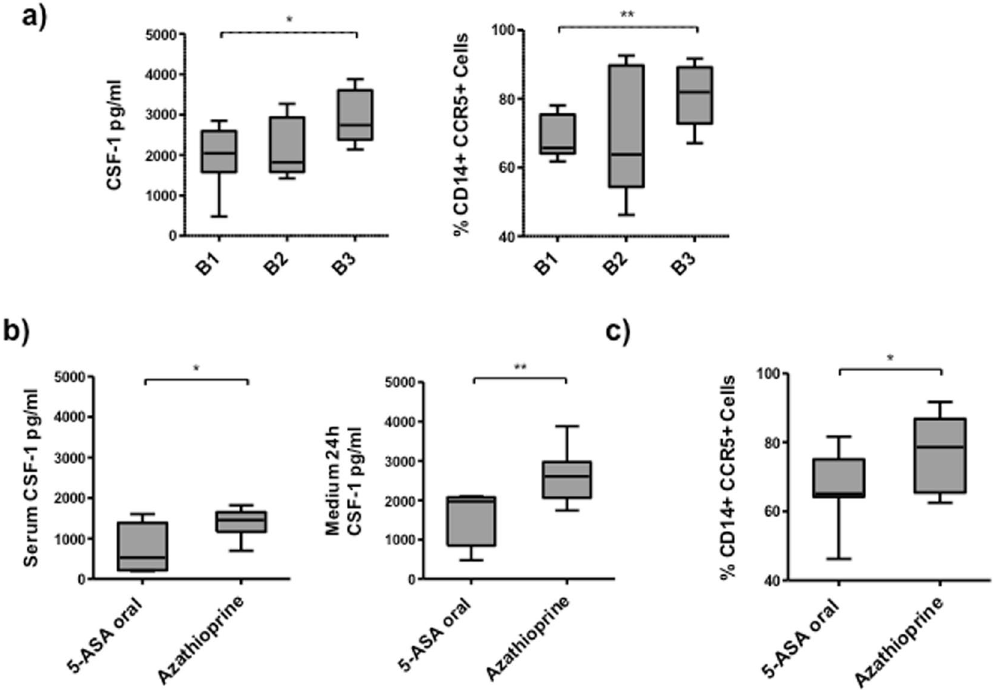
Figure 6. CSF-1 and CCR5 expression was associated with clinical behavior and treatment in CD patients in remission. ( a ) CSF-1 concentration and the percentage of CD14 + CCR5 + monocytes after 24 h of culture of peripheral blood from CD patients (n = 17) segregated according to clinical behavior (B1, B2, and B3). Multiple comparisons were calculated by ANOVA for levels of CSF-1 and the percentage of CCR5 + monocytes in regard to clinical behavior (p = 0.16, p = 0.08). ( b ) Concentration of CSF-1 in serum and in the supernatant of 24h-cultured peripheral blood monocytes from CD patients segregated according to treatment (5-ASA and azathioprine). ( c ) Percentage of CD14 + CCR5 monocytes from CD patients after 24 h of culture according to treatment (5-ASA and azathioprine). Wilcoxon test was used for the comparisons between treatment groups ( * p < 0.05, ** p <